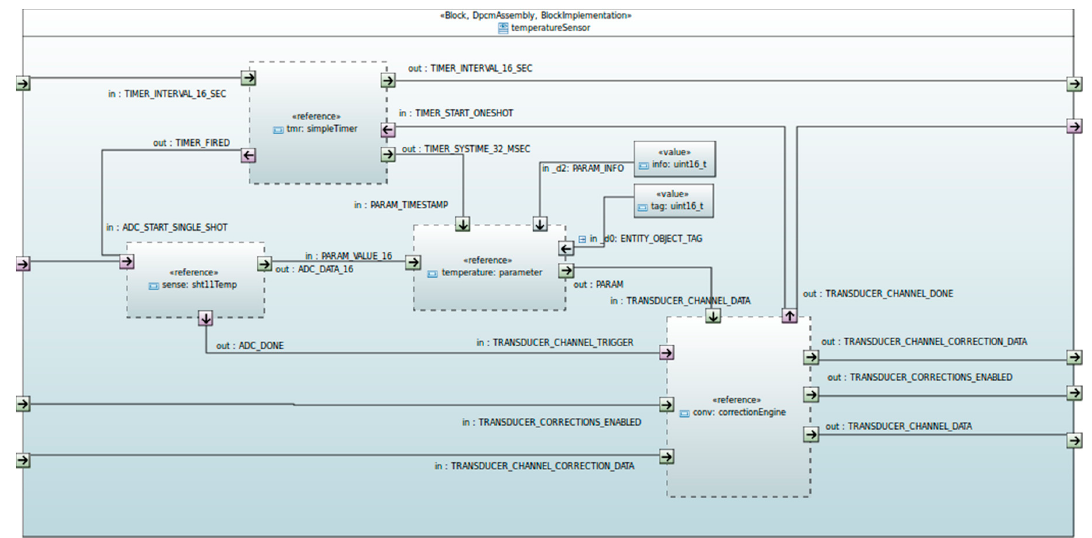
Figure 17. Middleware sensor assembly example.